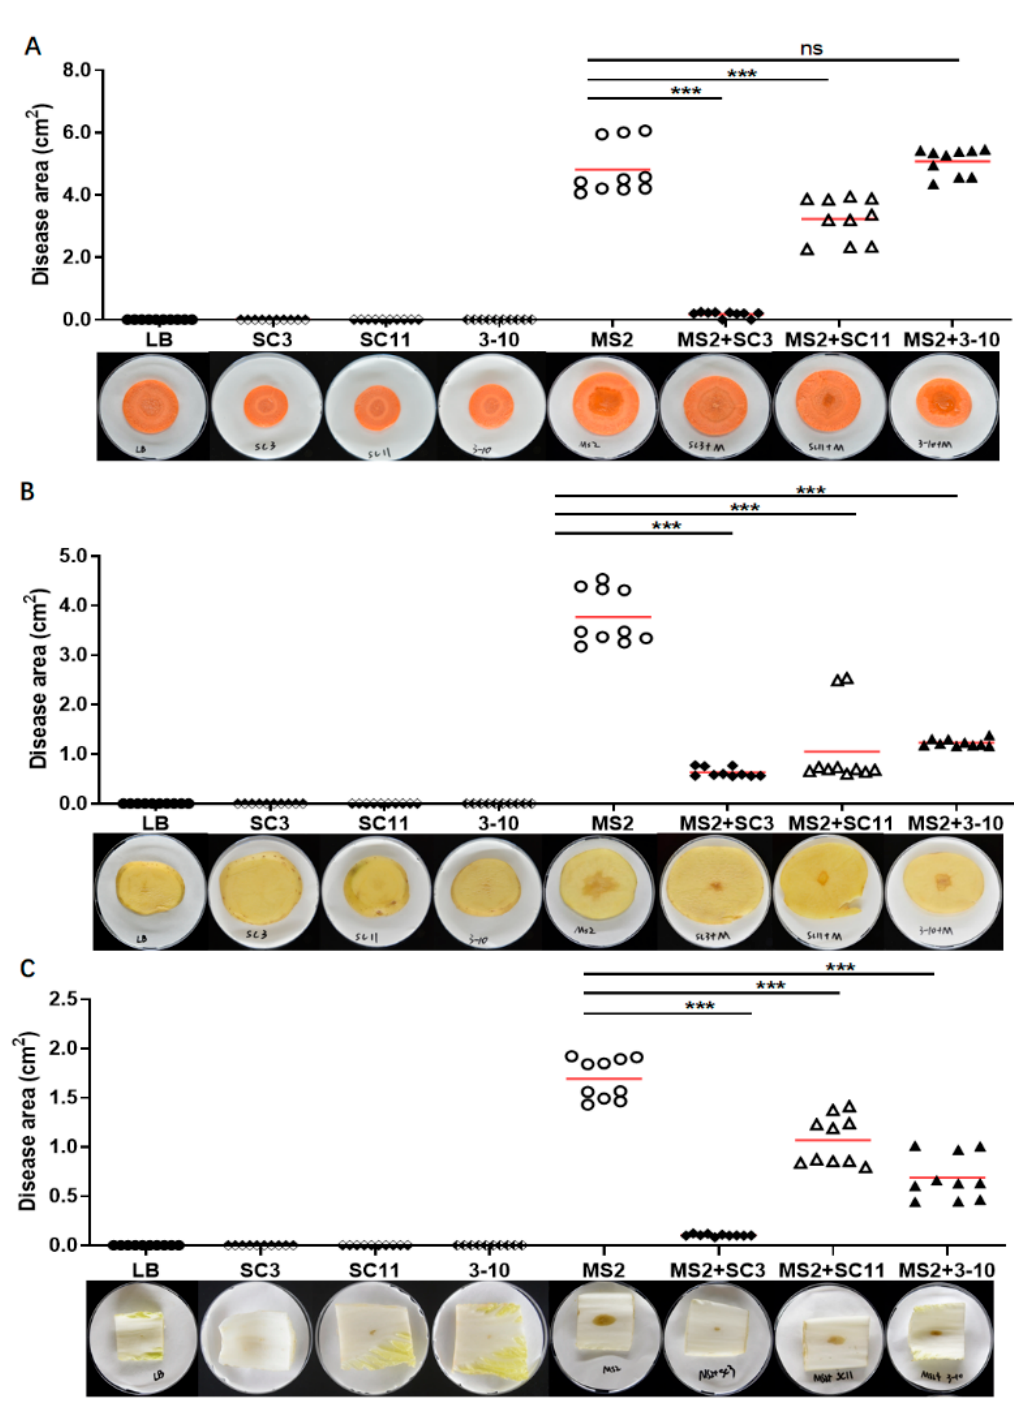
Figure 3. Biocontrol efficacy of antagonistic bacterial strains against soft rot disease on dicotyledonous carrot ( A ), potato ( B ) and Chinese cabbage ( C ). Both MS2 and antagonistic bacteria were grown in lysogeny broth (LB) medium till OD 600 ≈ 1.8. One microliter of LB, LB+antagonistic bacteria, LB+MS2 and MS2+antagonistic bacterium was respectively spotted onto the center of tissue slices. The rotting area was measured by Image J 1.52a, and the data were subjected to unpaired two-tailed t-test analysis by Graphpad Prism 8.4.1 (GraphPad Software, San Diego, CA, USA) (ns: no statistical significance, *** p < 0.001). The marks in the plot area represent the diseased area on 10 inoculated plant slices, and the red lines represent the average values of diseased area.